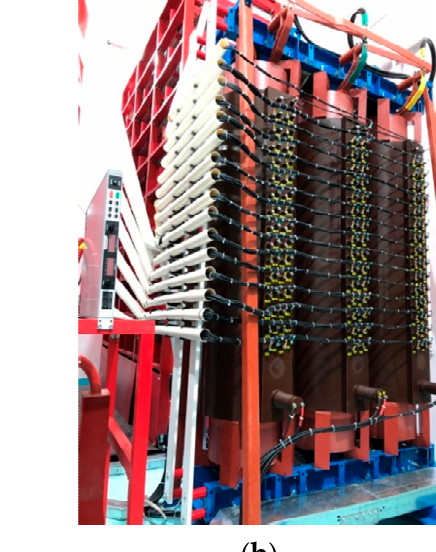
Figure 15. Measured voltage (modulating anode and main anode) and current of the 170 GHz gy- rotron. A gyrotron with a quasi-optical mode converter will be fabricated as soon as possi- ble to validate the quasi-optical mode converter performance and the heat dissipation